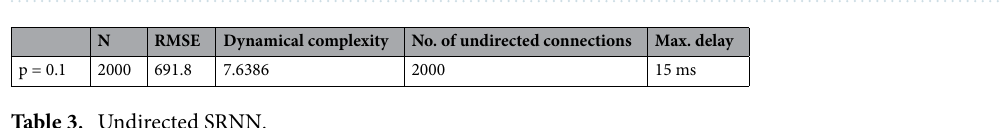
Figure 5. ( a ) Blue solid line shows Dynamical Complexity of undirected network. ( b ) Undirected biologically- plausible SRNN. Red dashed line shows “Modelled EEG signal”. Black solid line shows “Target EEG signal”. ( c ) Undirected topology Neuronal activity and MFR (raster plot) ( d ) Blue solid line shows Mean Weights update using biologically-plausible SRNN. ( e ) Blue solid line shows s.d. of Weights update using biologically-plausible SRNN. ( f ) Blue solid line shows RMSE of undirected network for varying maximum conductance delay.